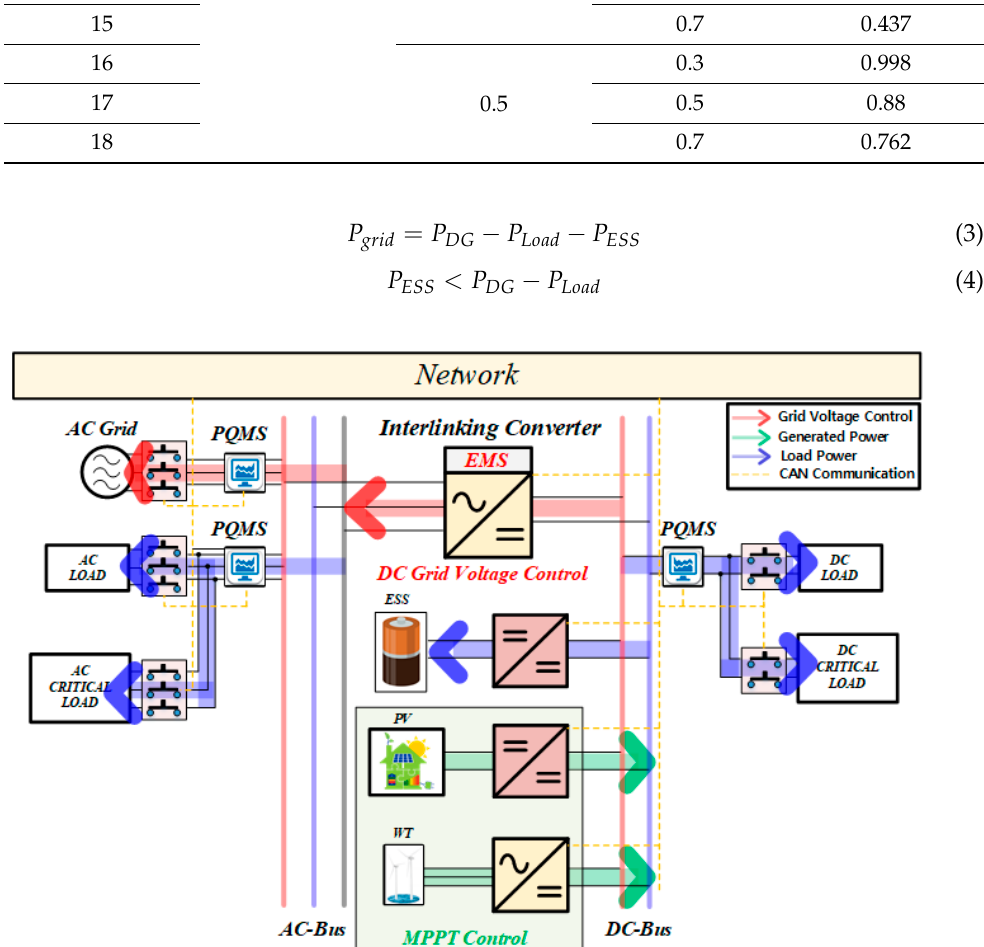
Figure 8. Power flow diagram of the power regeneration mode (mode 2). Table 2. ANN training data of mode 2.